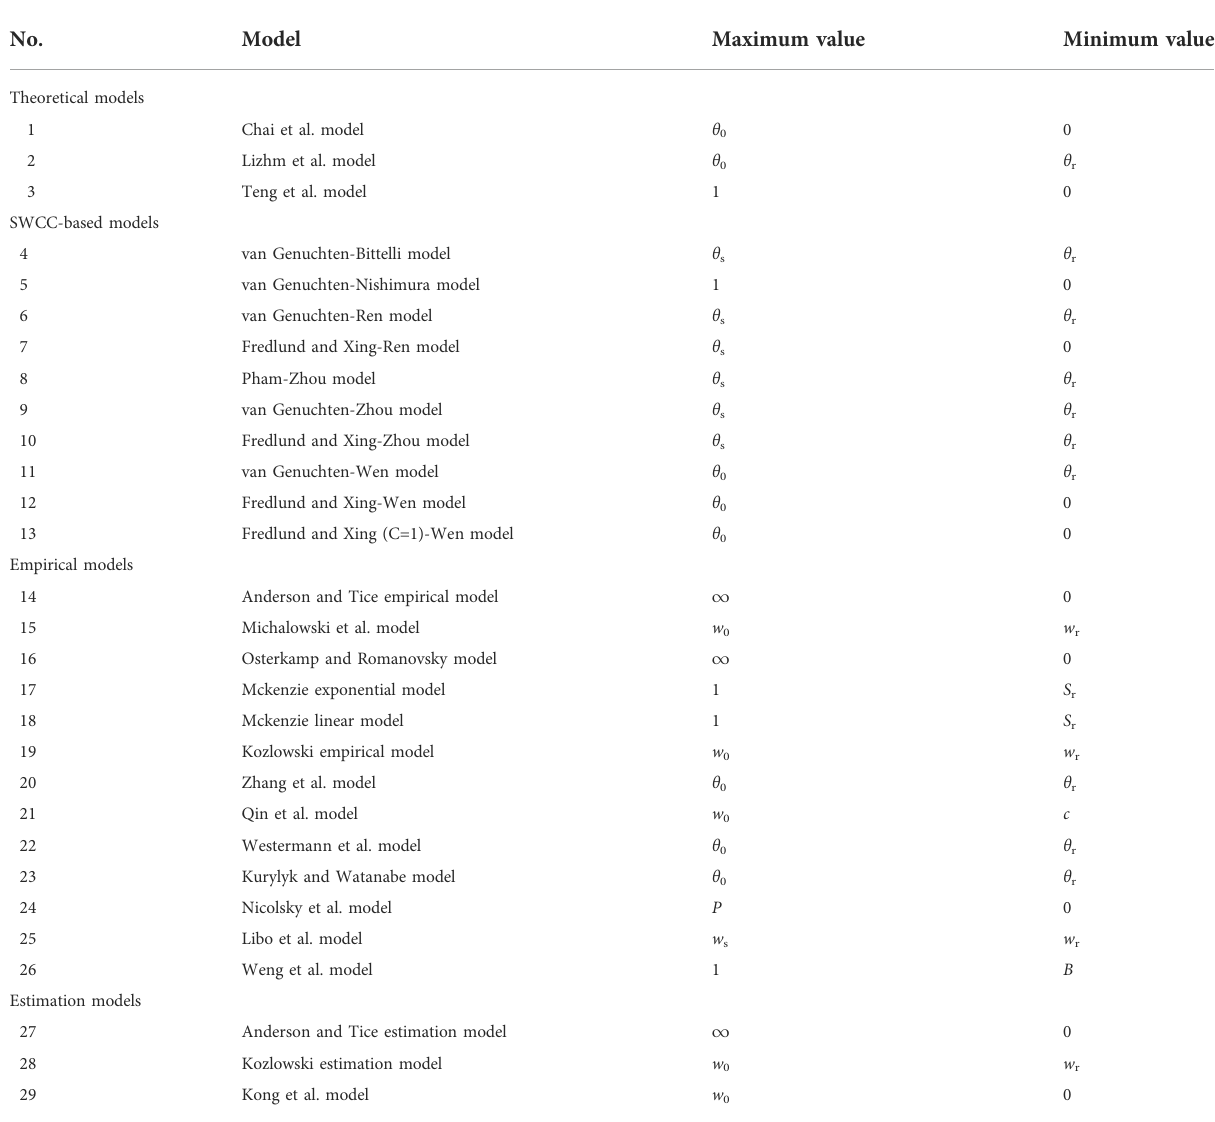
TABLE 2 The maximum and minimum values of unfrozen water content models.